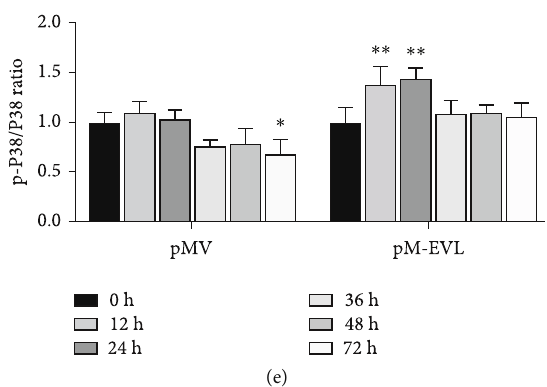
Figure 4: Involvement of the MAPK signaling pathway in EVL-mediated osteo-/odontogenic di ff erentiation of hDPSCs. (a) Western blot analyses of p38 MAPK, p-p38 MAPK, ERK, p-ERK, JNK, and p-JNK expressions were measured in hDPSCs transfected with si-EVL and si- NC. (b) Protein expression levels of p38 MAPK, p-p38 MAPK, ERK, p-ERK, JNK, and p-JNK in hDPSCs transfected with pMV and pM- EVL. (c) The p-JNK/JNK ratio was measured in hDPSCs transfected with pMV and pM-EVL. (d) The p-JNK/JNK ratio was measured in hDPSCs transfected with si-EVL and si-NC. (e) The p-p38/p38 ratio was measured in hDPSCs transfected with pM-EVL and pMV. Data are shown as the mean ± SD ( n = 3 ); ∗ P ≤ 0 : 05 , ∗∗ P ≤ 0 : 01 , ∗∗∗ P ≤ 0 : 001